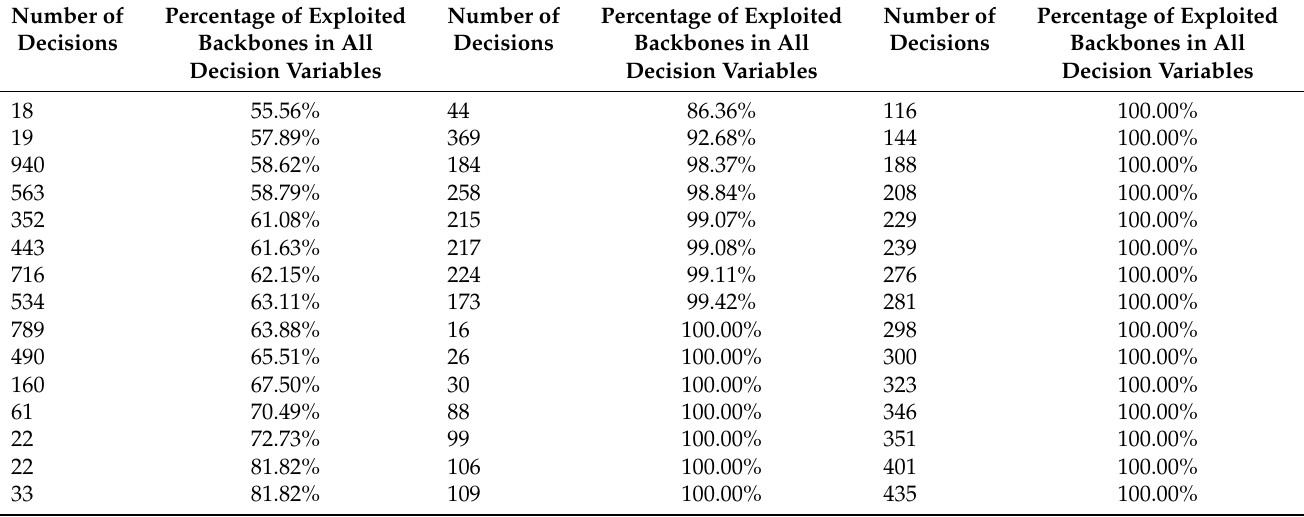
Table A4. Reported crafted instances from experiment in Figure A8 that are solved in fewer than 1000 decisions.